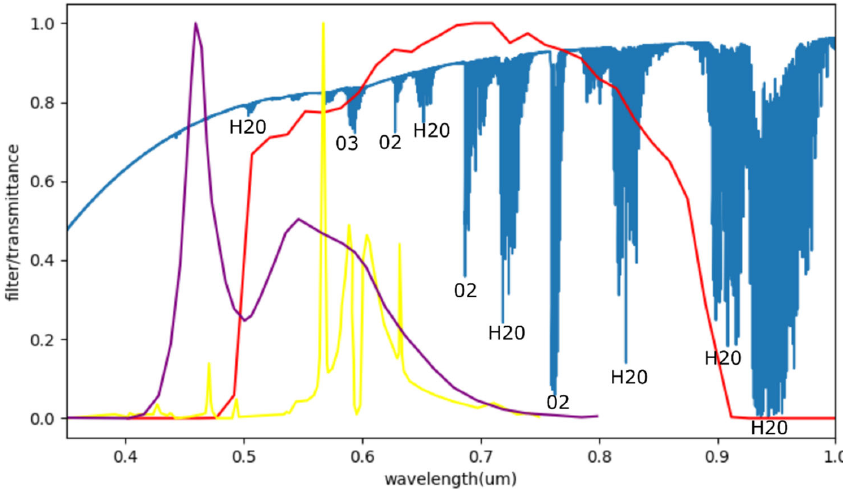
Figure 8. VIIRS/DNB spectral response (red), HPS (yellow) and LED (purple) spectra, and Atmo- spheric Spectral Transmittance (blue).